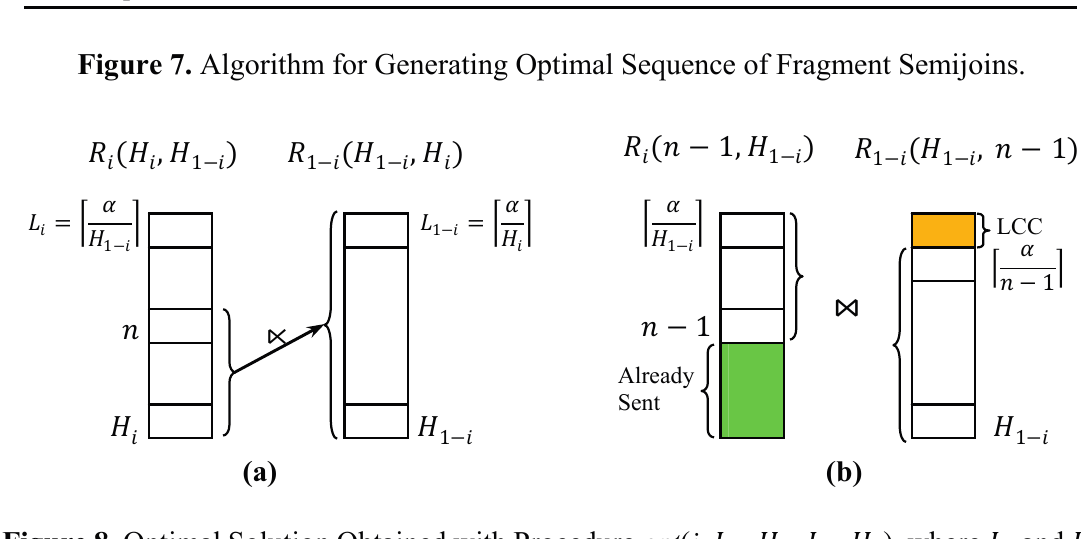
, (cid:1834) , (cid:1838) , (cid:1834) ), where (cid:1838) and (cid:1834) (cid:2868) (cid:2868) (cid:2869) (cid:2869) (cid:3036) (cid:3036) . ( a ) The optimal value of n (cid:3036) (cid:2869)(cid:2879)(cid:3036) ((cid:1834) , (cid:1866) − 1) , for ⋉(cid:3365)∗ (cid:2869)(cid:2879)(cid:3036)